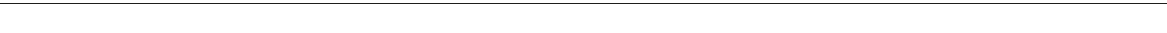
Fig. 3 Effects of miR-100 and miR-125b on EMT and stemness. a Phase-contrast images of BxPC-3, PANC-1, and CHX45 cells treated with control mimic (pre-nc) or mature miRNA mimics (pre-miRs) for 12 days (5 nM). Scale bar: 100 µ m. b Immuno fl uorescence (IF) staining for CDH1 (red) and F-actin (green) in BxPC-3 treated as in a . Nuclei are visualized with TO-PRO-3 stain (blue); scale bar: 20 µ m. In a , b representative images from three independent experiments are shown. c Morphology of S2-007 stable knockdown clones for miR-100 (Z100), miR-125 (Z125b), and control (Zc) generated with Zip technology. Representative pictures from two different clones per treatment are shown. Phase-contrast images are shown at the top and corresponding GFP images at the bottom. Scale bar: 400 µ m. d – f Sphere-forming assays in BxPC-3 cells transiently transfected with precursor miRNA mimics ( d ), in PANC-1 cells treated with anti-miRNA inhibitors ( e ), and in four independent PANC-1 Zip stable knockdown clones ( n = 4) ( f ). Representative spheres are shown in lower panels in phase-contrast images and corresponding GFP images. Values represent the mean ± s.e.m. Data are from three independent experiments each performed in triplicate. g Mice were subcutaneously injected with the indicated number of S2-007 Zip control cells (Zc-11) on the right fl ank and S2-007 Zip stable miR-100 knockdown (Z100-3) or miR-125b knockdown (Z125b-5) on the left fl ank ( n = 5 per group). Tumor take was determined 3 weeks post-injection. Cancer stem cell (CSC) frequencies were calculated using the extreme limiting dilution analysis algorithm (http:// bioinf.wehi.edu.au/software/elda/). h Images of resected tumors are shown. ** P -value < 0.01, *** P -value < 0.001. P -values were calculated using